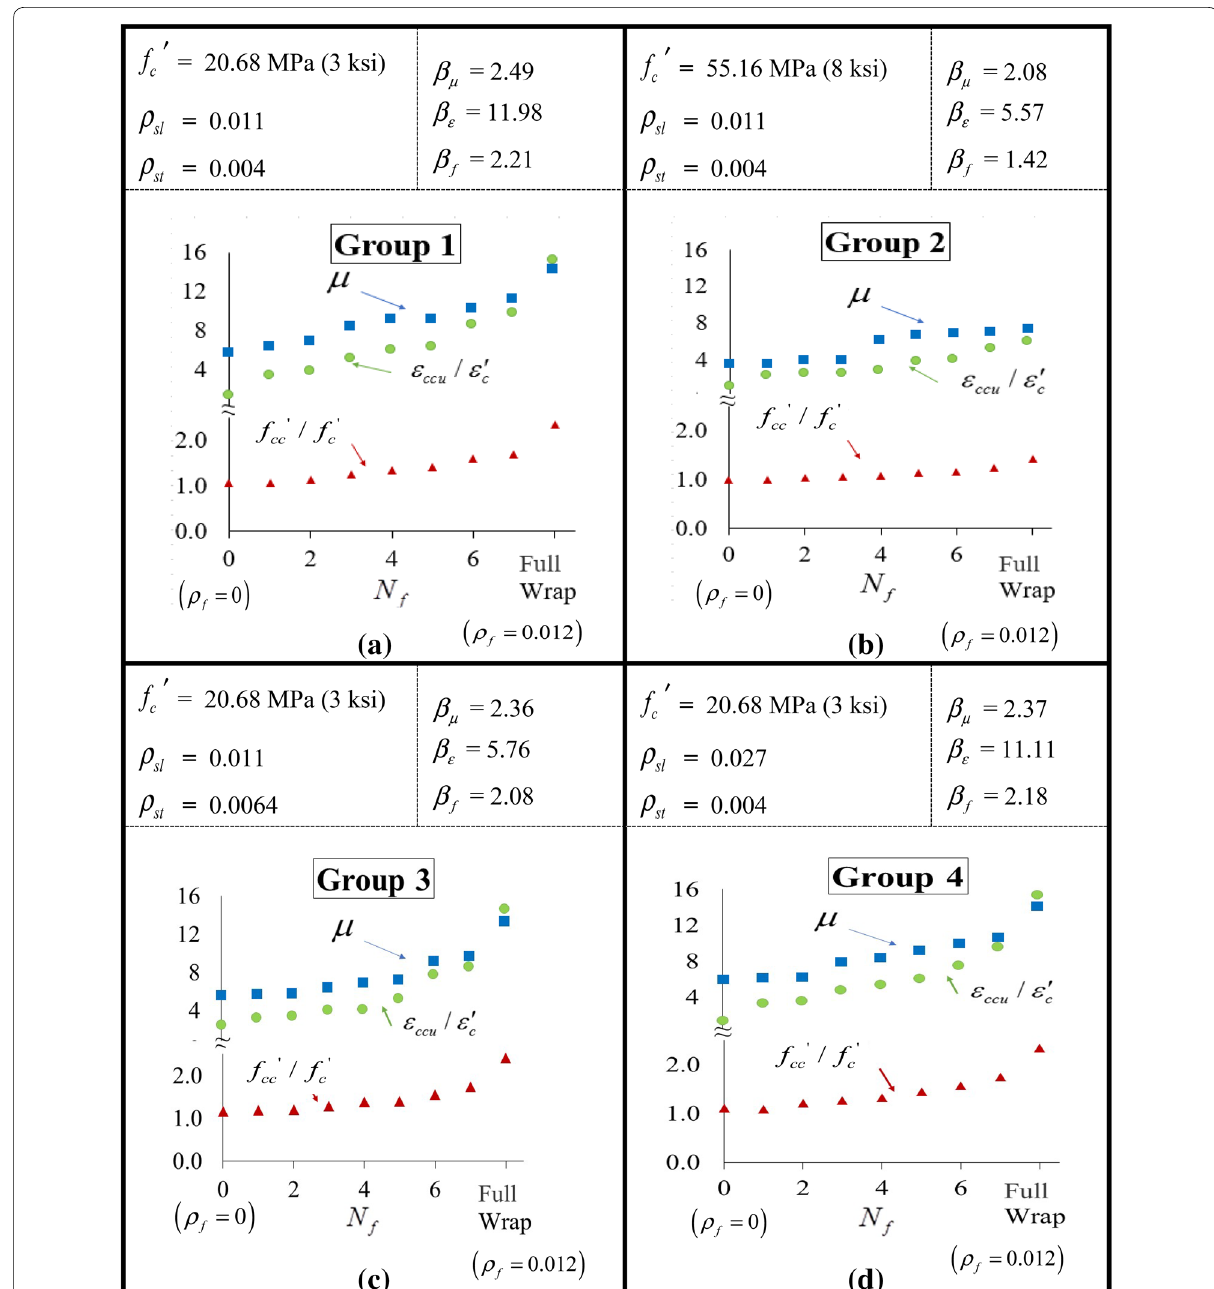
, and ductility factor (μ) vs number of strips ( N f ) for the columns in a Group 1, b Group 2, c Group 3, and d Group